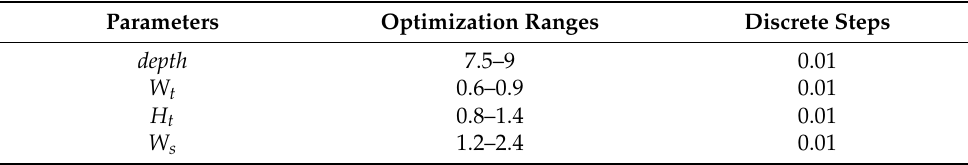
Table 4. Optimization parameters, ranges, and discrete steps.